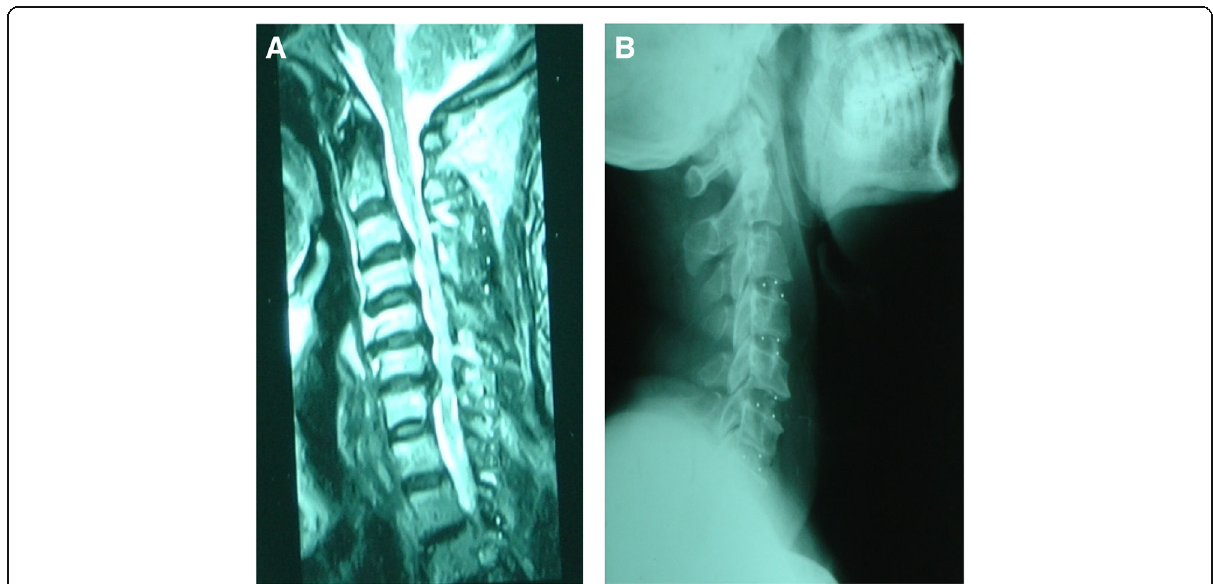
Fig. 1 a Preoperative MRI showing C3 – 4, 4 – 5, 5 – 6, and 6 – 7 disc prolapse. b Postoperative plain X-ray of the cervical spine lateral view